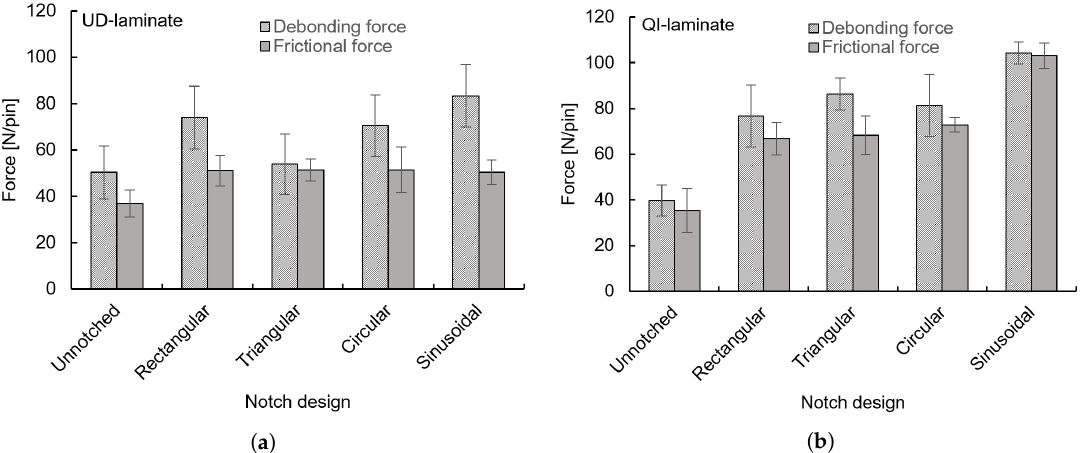
Figure 5. Mean values and corresponding standard deviation values of debonding and frictional forces during pin-pullout of unnotched and circumferentially notched z-pins with different notch designs and constant notch depths of 20 µ m as well as notch distances of 100 µ m in a ( a ) unidirectional and ( b ) quasi-isotropic laminate